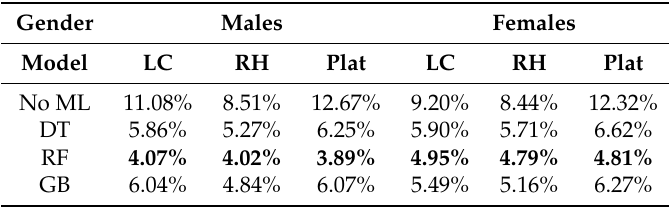
Table 5. MAPE of fitted with respect to observed data for the LC, RH, and Plat model, before (No ML) and after (DT, RF, GB) the application of ML algorithms. Ages 0–100 and years 1960–2014, Italian population. Values in bold indicate the specification with the smaller MAPE for each